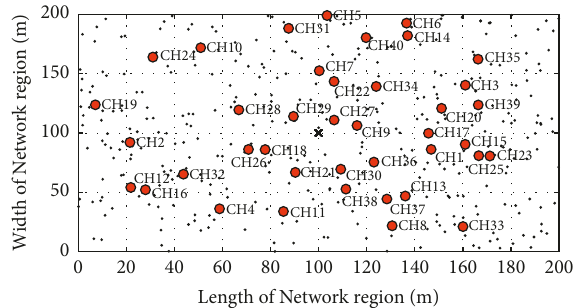
Figure 6: Random deployment of a wireless sensor network with 400-nodes and 40 CHS selected by MRFO algorithm.